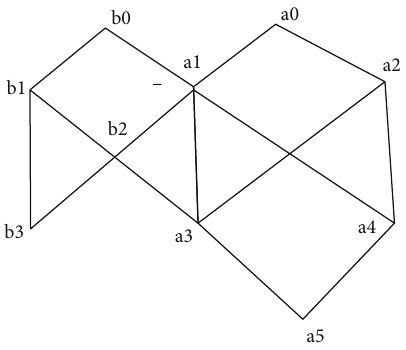
Figure 1: Example of a complete